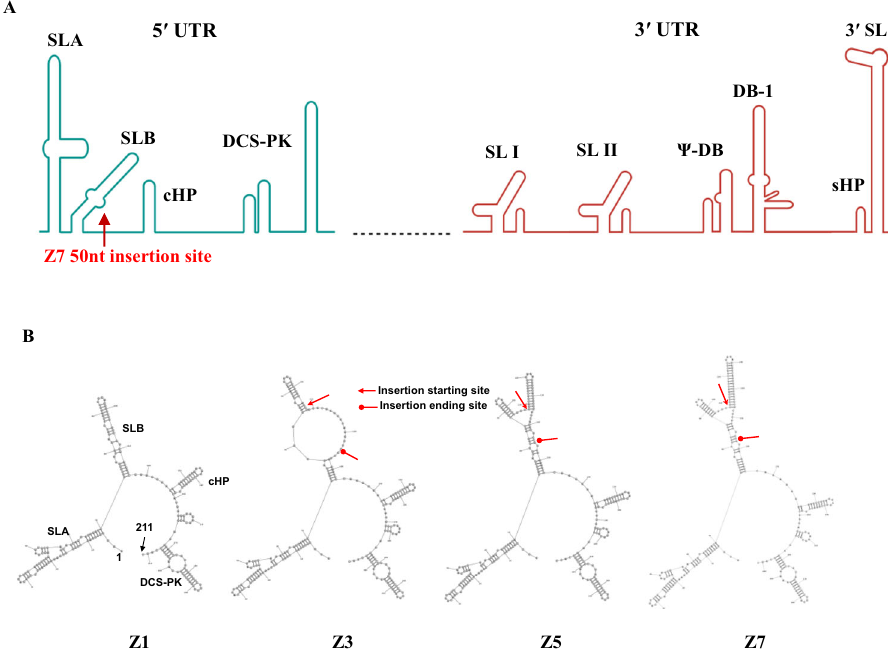
Fig. 1 Generation of mutant ZIKV by modifying 5 ′ UTR. A The insertion site of the GC-rich nucleotides in the 5 ′ UTR of the ZIKV genome 73 . The illustration was created with BioRender. B The predicted secondary structures of Z1 (WT, no insert), Z3 (18-nt insert), Z5 (38-nt insert), and Z7 (50-nt insert) by